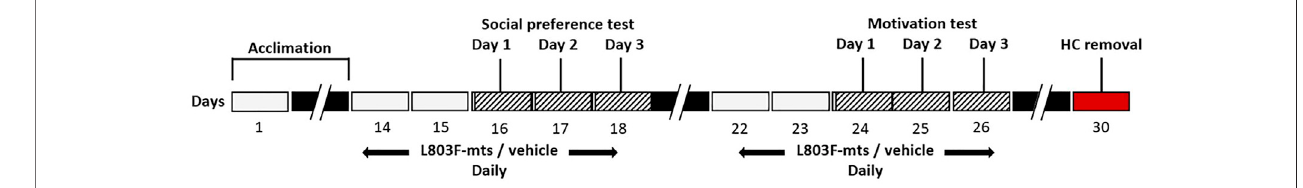
FIGURE 1 | A schematic depiction of the study. Black rectangles represent time gaps. See text for